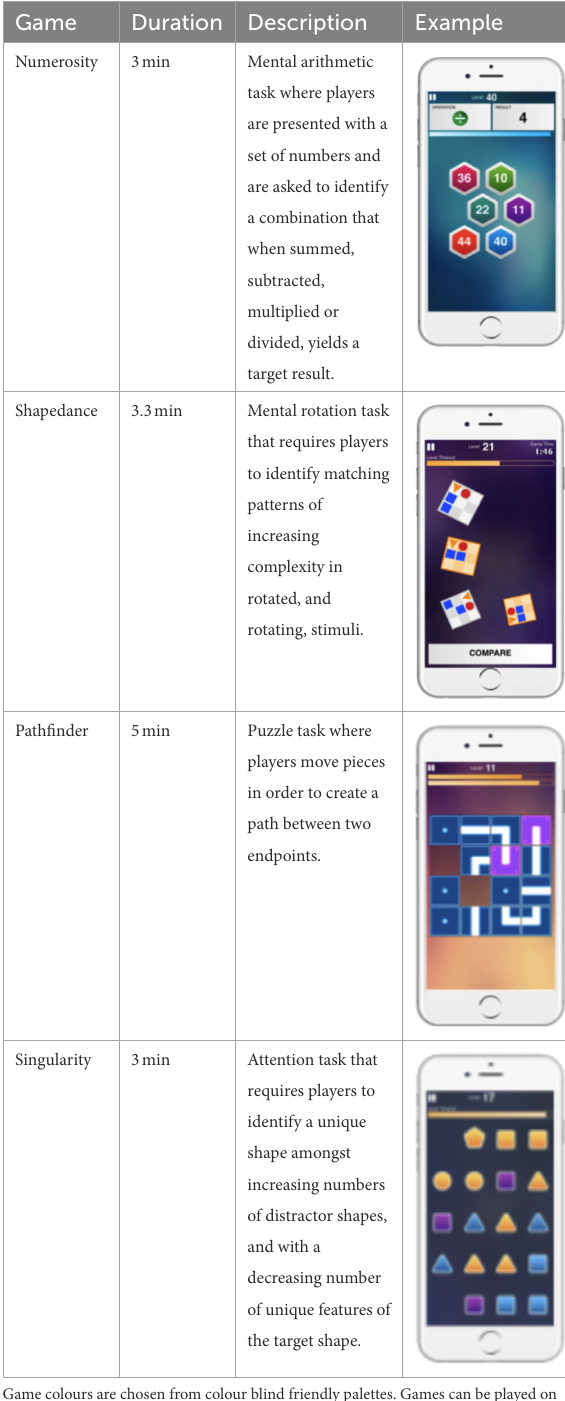
TABLE 2 Game descriptions, duration, and example